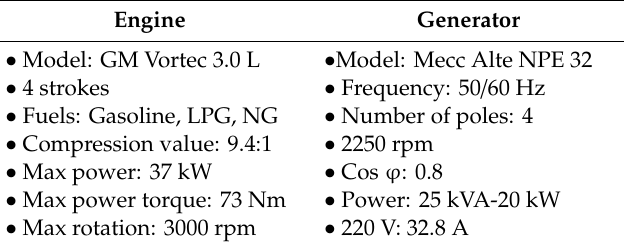
Table 2. Main characteristics of the generation system.